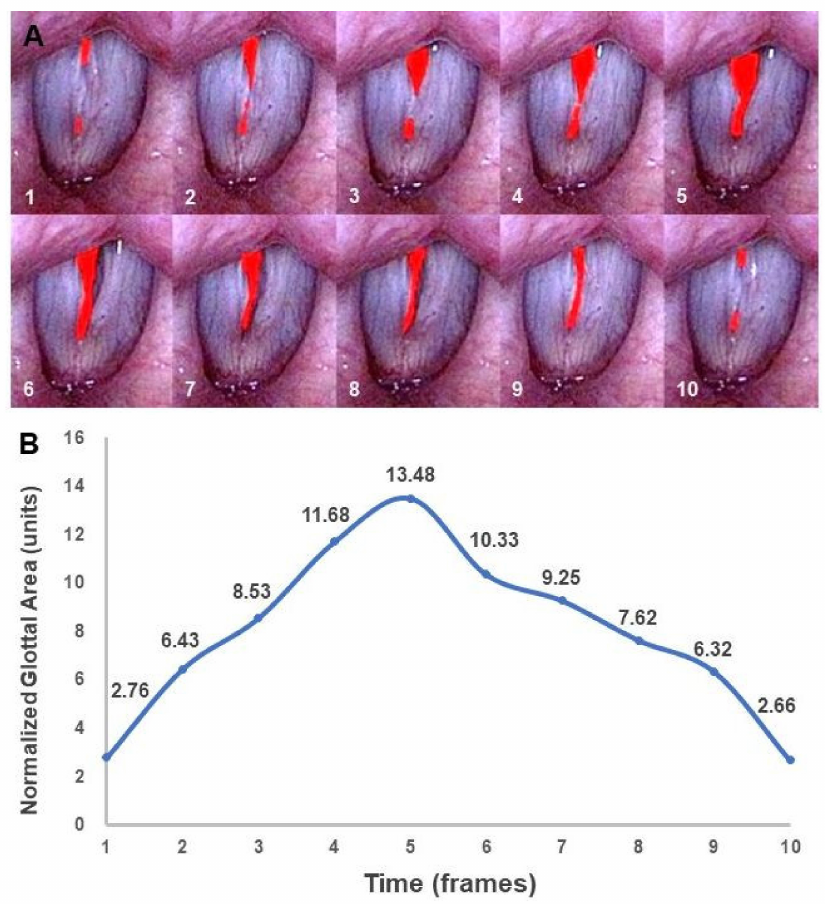
Figure 1. Glottal area for patients with vocal fold nodules. ( A ) A 10-frame sequence of the glottal area (the red-colored area). ( B ) Dynamic change of the normalized glottal area corresponding to the glottal